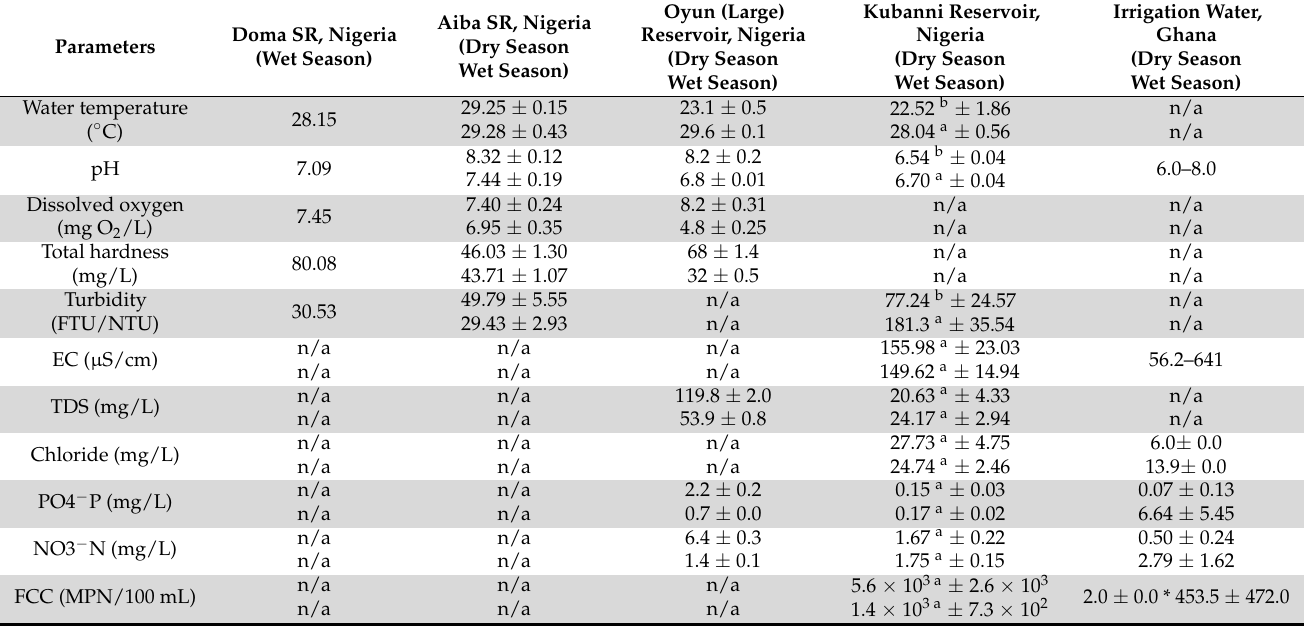
Table 11. Mean values of water quality parameters of the selected reservoirs